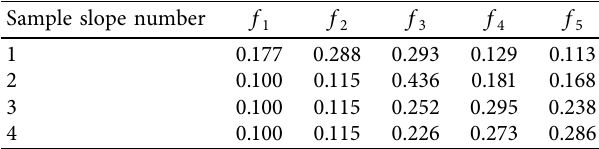
Table 8: Comprehensive connection degree of